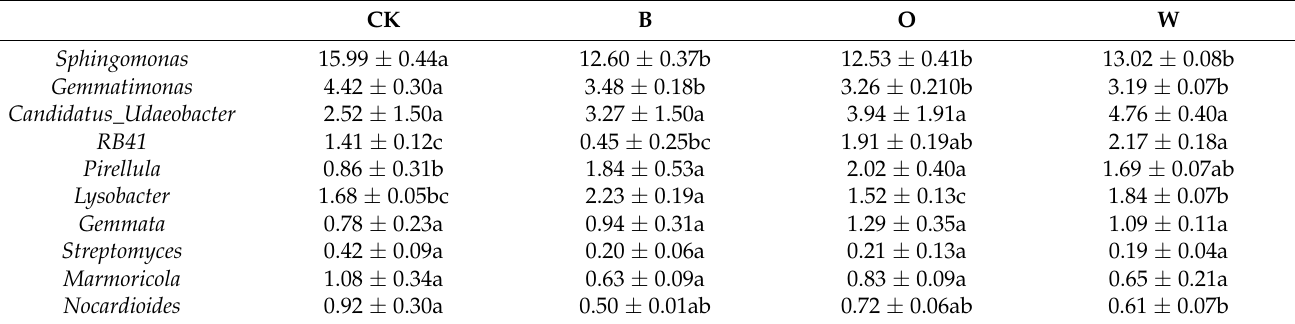
Table 2. Relative abundances of dominant bacterial genera in soil.